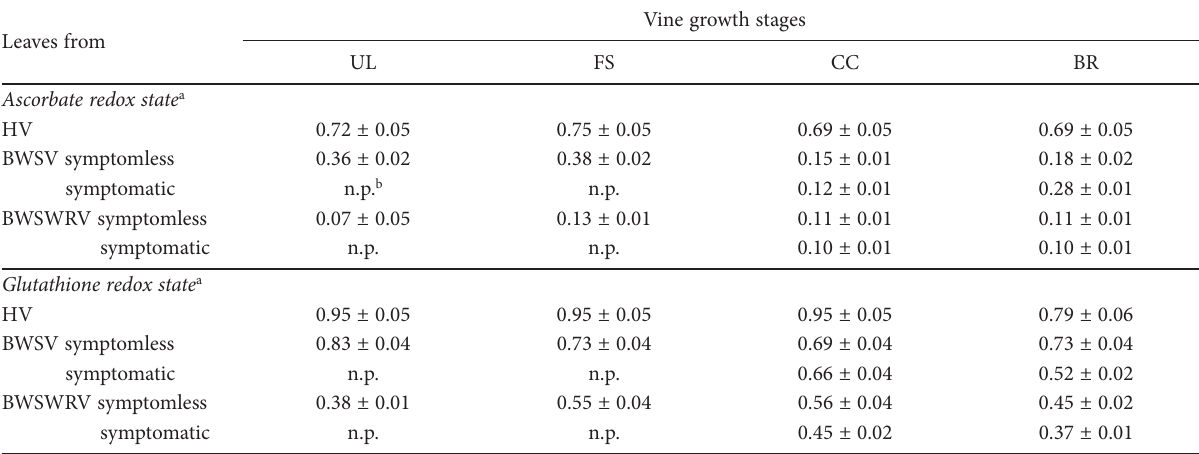
Vine growth stages